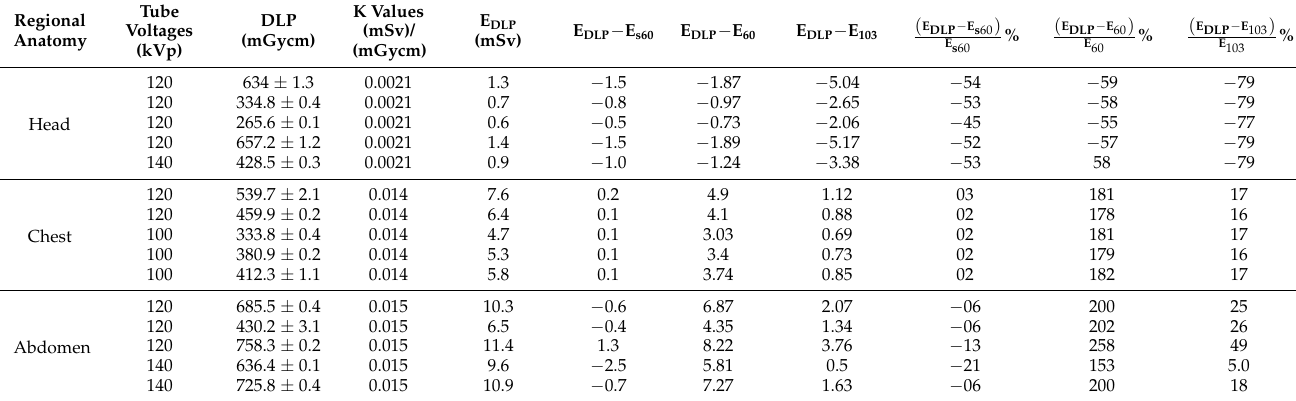
Table 3. DLP-based effective dose estimates and comparison for ICRP 60, 103 and CT-Expo.